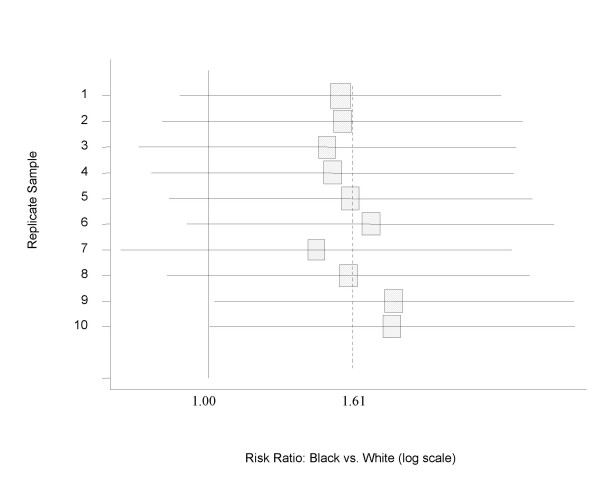
Results of regression analysis for race with the dependent variable assessment of oxygen saturation within 24 hours. Forest plot demonstrating the results of the 10 individual conditional logistic regressions models for the dependent variable assessing oxygen saturation within 24 hours after adjusting for severity of illness using the PSI. The presented relative risk with 95% confidence intervals is for the independent variable race (dichotomized into black versus white).